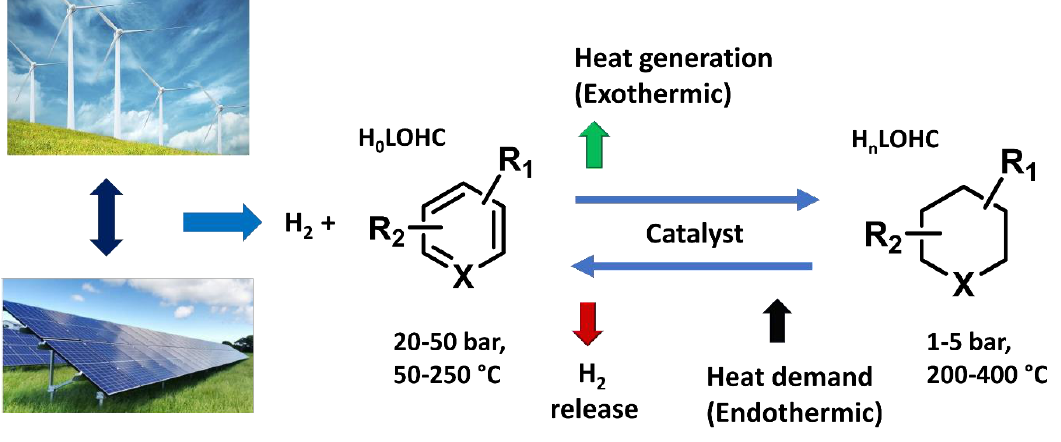
Scheme 1. Schematic representation of the LOHC